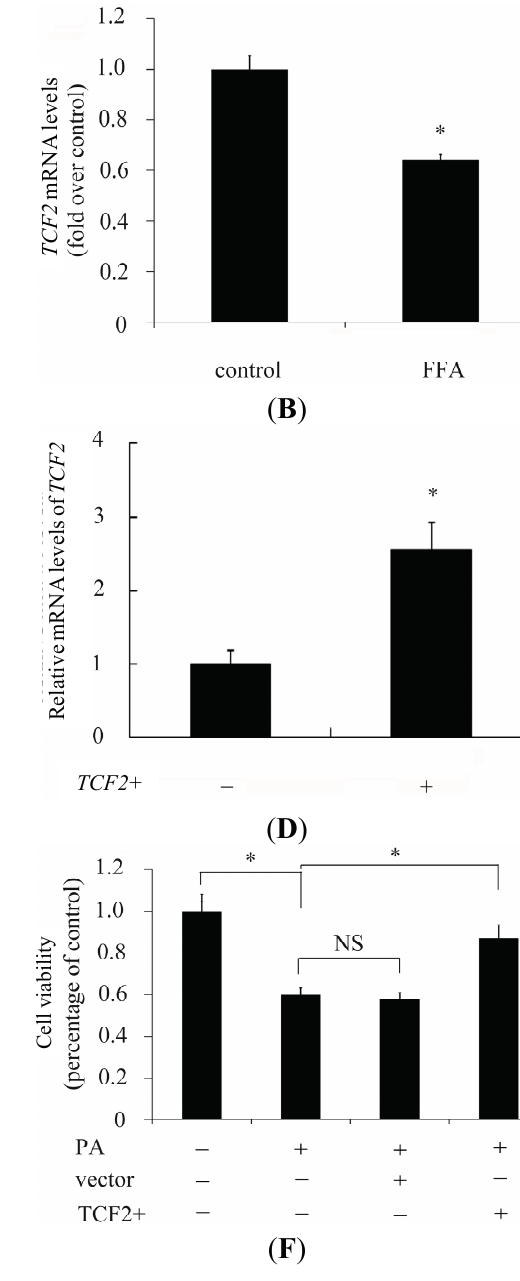
Figure 1. High concentrations of palmitic acid (PA) inhibit the expression of transcription factor 2 ( TCF2 ) in β -cells. Viability of INS-1 β -cells was analyzed after treatment with a concentration gradient concentration of PA for 48 h, then 0.5 mg/mL 3-(4,5-dimethyl- 2-thiazolyl)-2,5-diphenyl-2 H -tetrazolium bromide (MTT) was added and cells were cultured for further 4 h to evaluate cell viability ( A ); TCF2 expression was evaluated by RT-PCR ( B ); and Western blotting ( C ) in INS-1 cells with or without (control) pretreatment with PA (800 μ M); The transfection effect of adenovirus containing the TCF2 was evaluated by RT-PCR ( D ); And Western blotting ( E ); Viability of INS-1 cells pretreated with PA (800 μ M) and overexpressing TCF2 or transfected with the control vector was analyzed ( F ). * p < 0.05. NS means no statistically